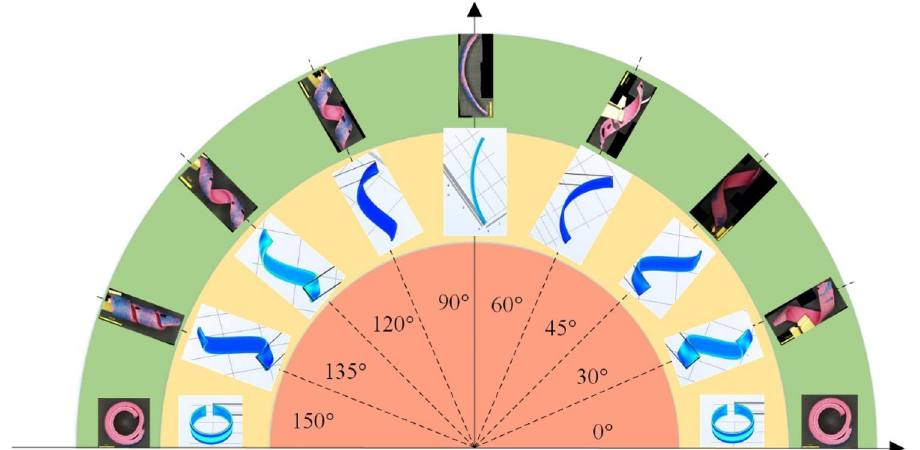
Figure 7. Simulation and experiment for different printing